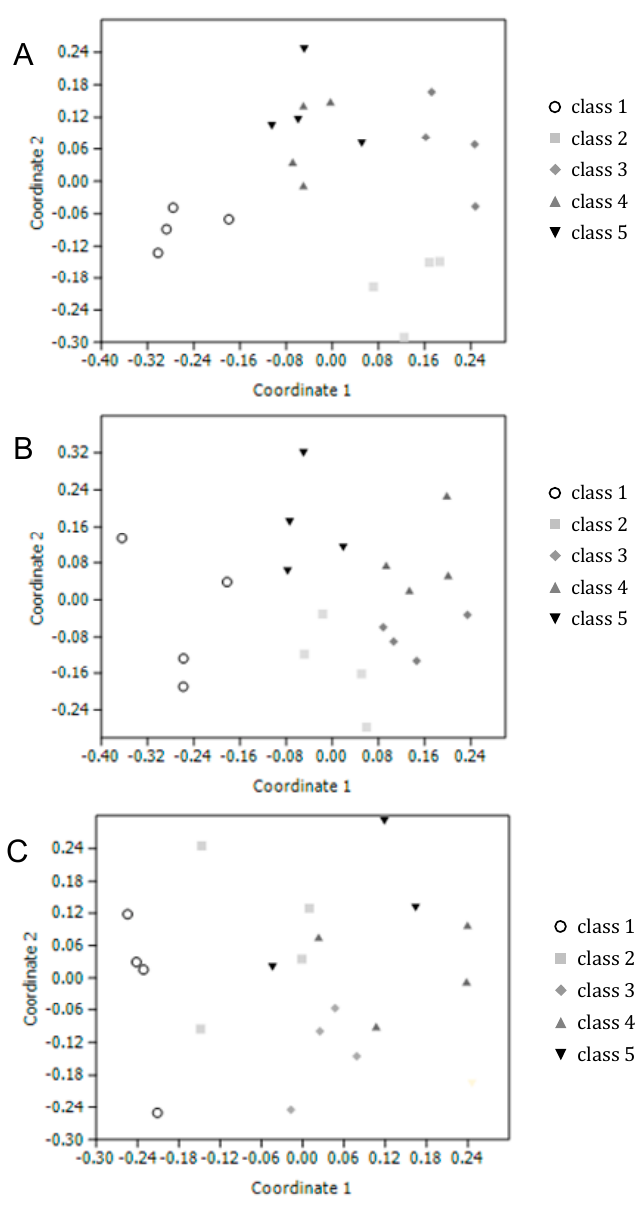
Figure 2. MDS ordination plots of fungal 18S rDNA ( A , stress = 0.270); bacterial 16S rDNA ( B , stress = 0.261); and actinobacterial 16S rDNA ( C ; stress = 0.344) obtained from black pine deadwood. Table 3. ANOSIM and PERMANOVA global tests based on the Dice similarity matrices of 18S- and 16S-DGGE, for microbial groups in decaying black pine